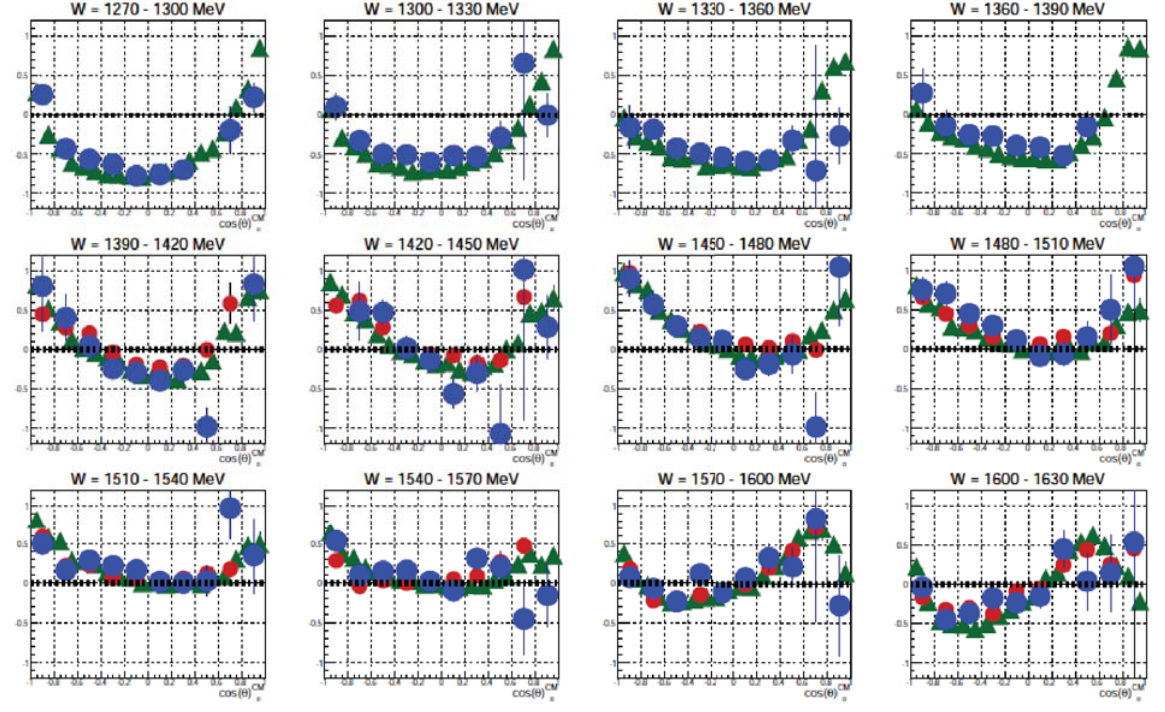
Figure 6. Results for the double polarisation observable E for the photoproduction channel γ p → π 0 p , as a function of cos θ CM selected 30 MeV energy bins, for free (green triangles) and quasi-free (blue circles) protons [20]. For W CM > 1390 MeV, the data are also compared to the results in [19].